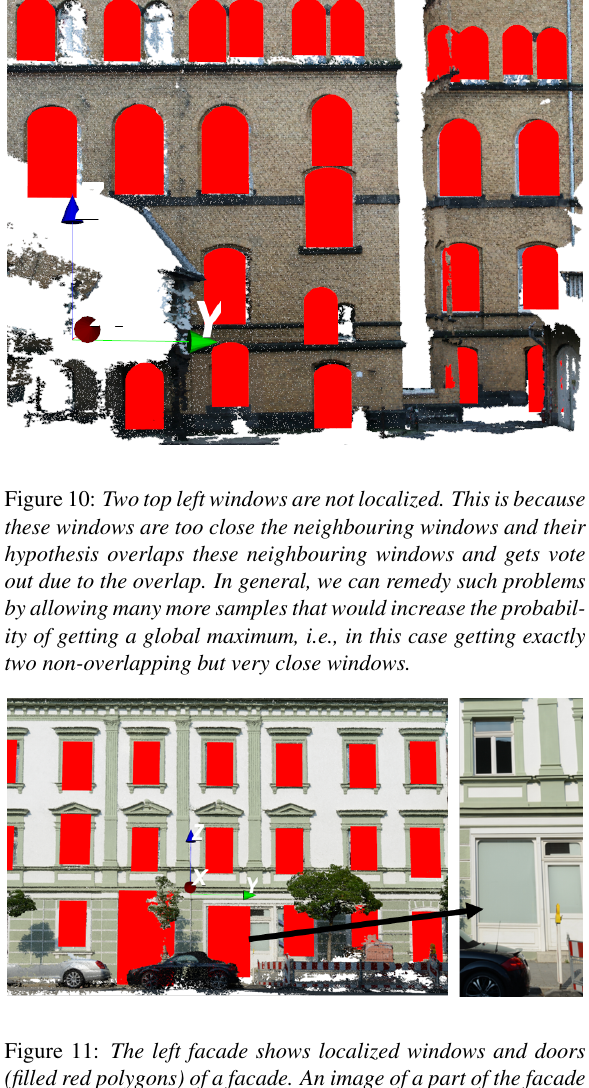
Figure 11: The left facade shows localized windows and doors (filled red polygons) of a facade. An image of a part of the facade is depicted on the right. The arrows shows a false localization of a door.